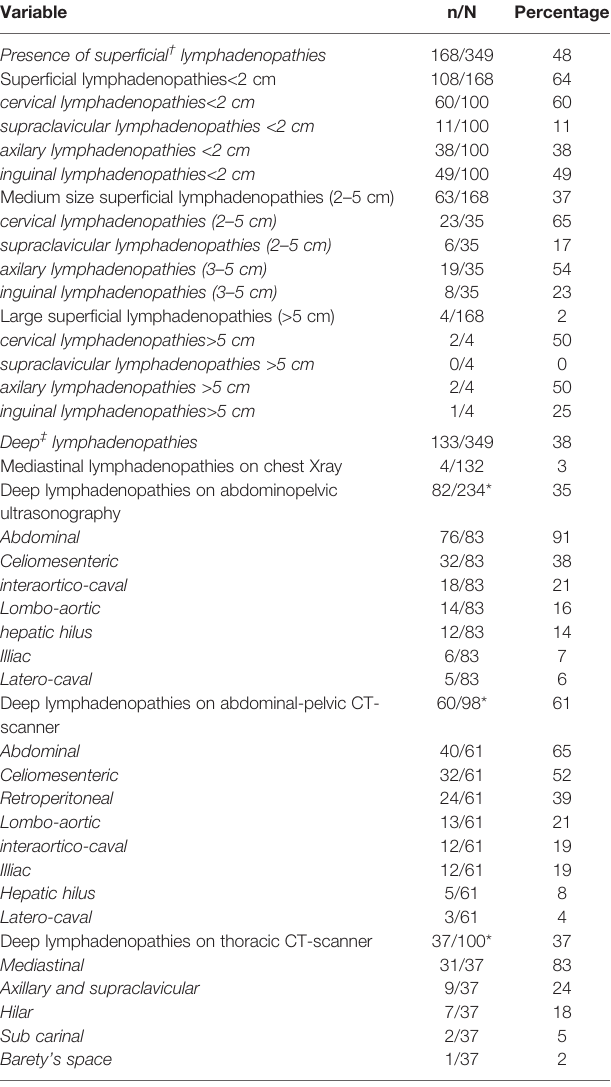
TABLE 1 | Super fi cial and deep lymphadenopathies in human immunode fi ciency virus (HIV)-infected patients with disseminated histoplasmosis.